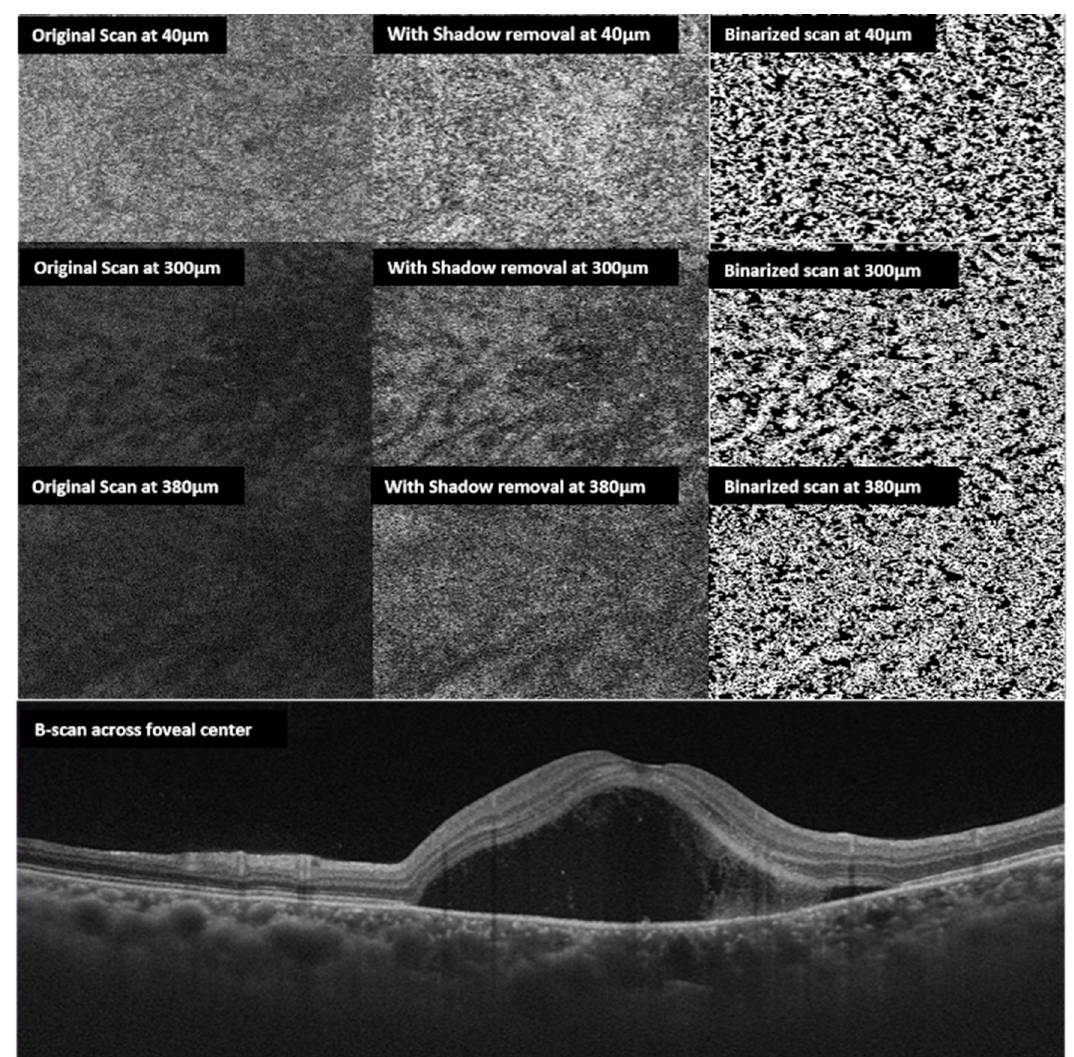
Figure 4. En face choroidal vascularity: multiple en face scans obtained at 40, 300, 380 µm from the Bruch’s membrane top to bottom respectively (left side). The middle column shows en-face scans following shadow removal. The right column shows corresponding binarized scans. The bottom horizontal B scan shows the neurosensory detachment of the same eye with CSCR.